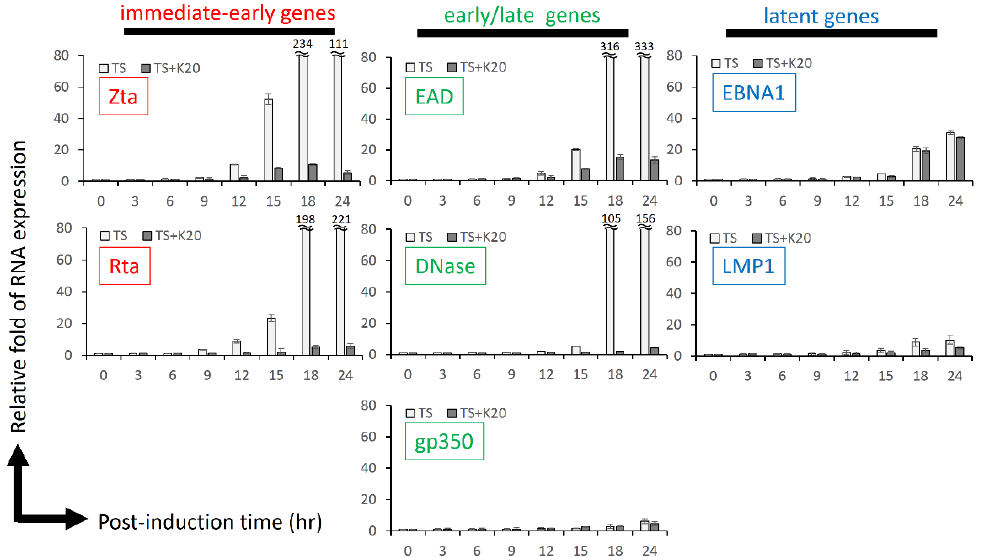
Figure 4. The mRNA expression of EBV lytic genes under kaempferol treatment in NPC cell line. To detect the mRNA expression of activating EBV after kaempferol treatment, NA cell lines were pre-treated with kaempferol or not, and then TPA + SB was added to induce EBV reactivation. The mRNAs extracted from each sample at different time points were subjected to RT-qPCR, as described in the Materials and Methods section. Several lytic genes (Zta, Rta, EAD, DNase, and gp350) and latent genes (EBNA1 and LMP1) were examined. The values of each sample were derived from three independent trials. The relative fold of RNA expression was represented as the relative fold of mRNA expression compared to 0 h group. TS: TPA + SB; K2: 20 μM kaempferol.